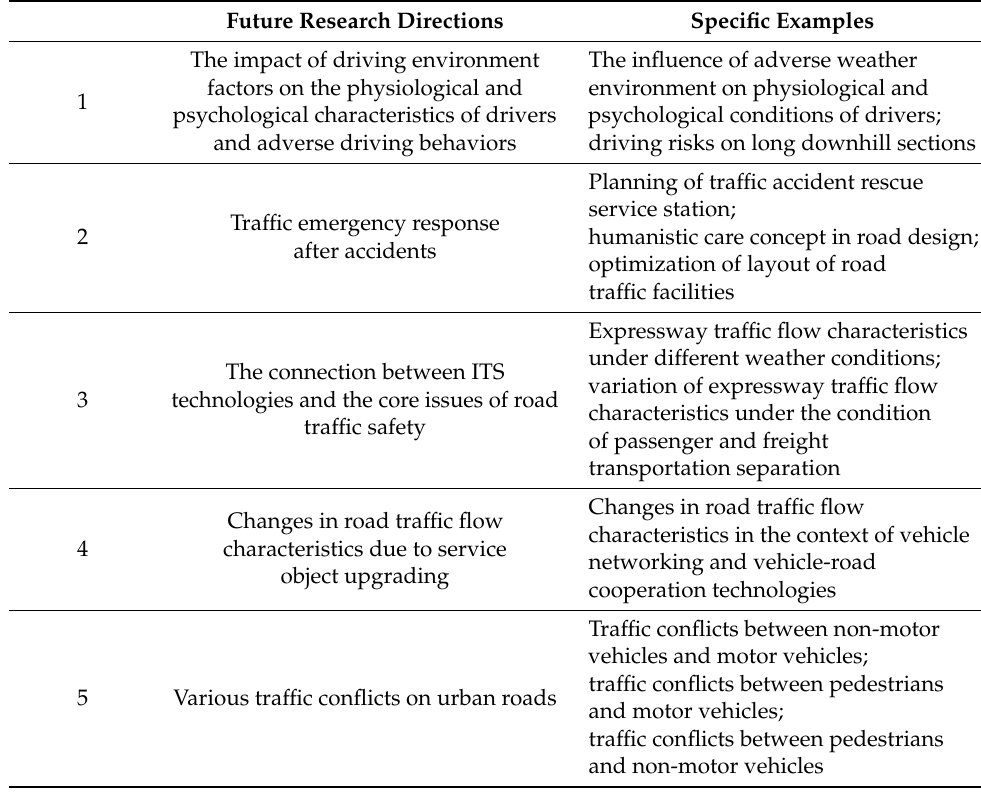
Table 1. Future research directions based on